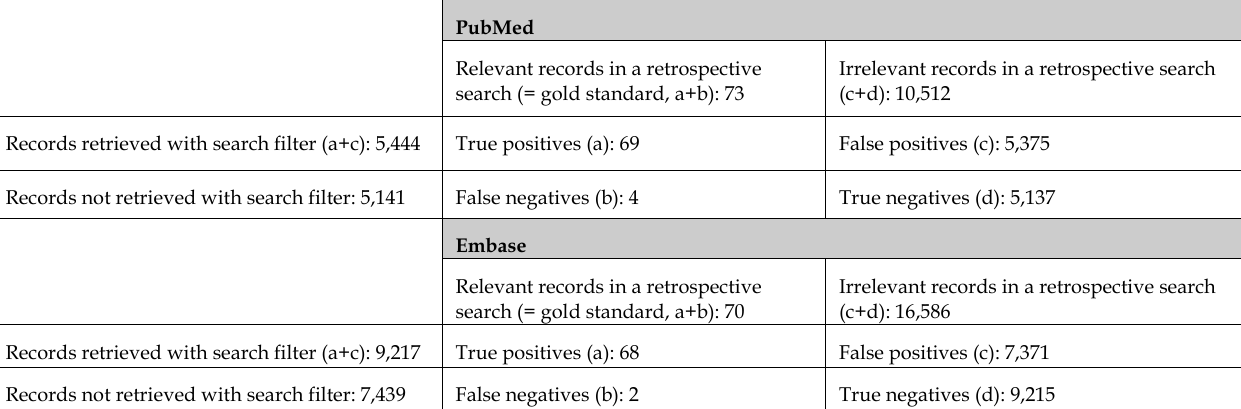
Table 5 Overview of the adapted intervention study search filter’s performance in PubMed and Embase in the validation reference gold